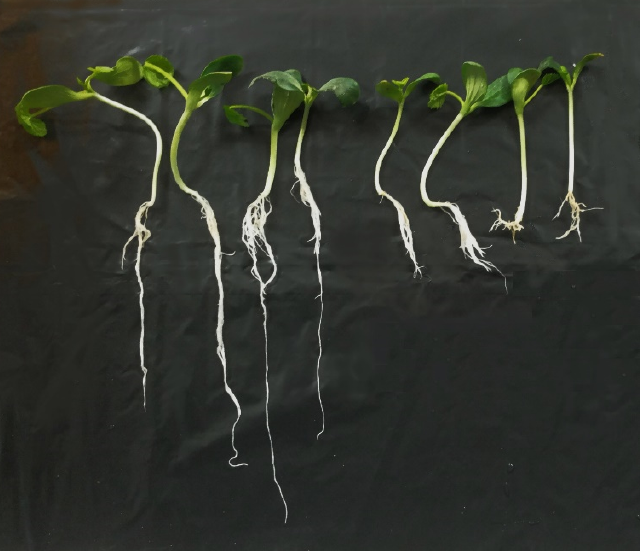
Figure 6. Pathogenicity test of Pythium ultimum 22 towards zucchini plantlets. Effect of development reduction of the root apparatus in plantlets from the inoculated trays (right) compared to the non- inoculated control (left).